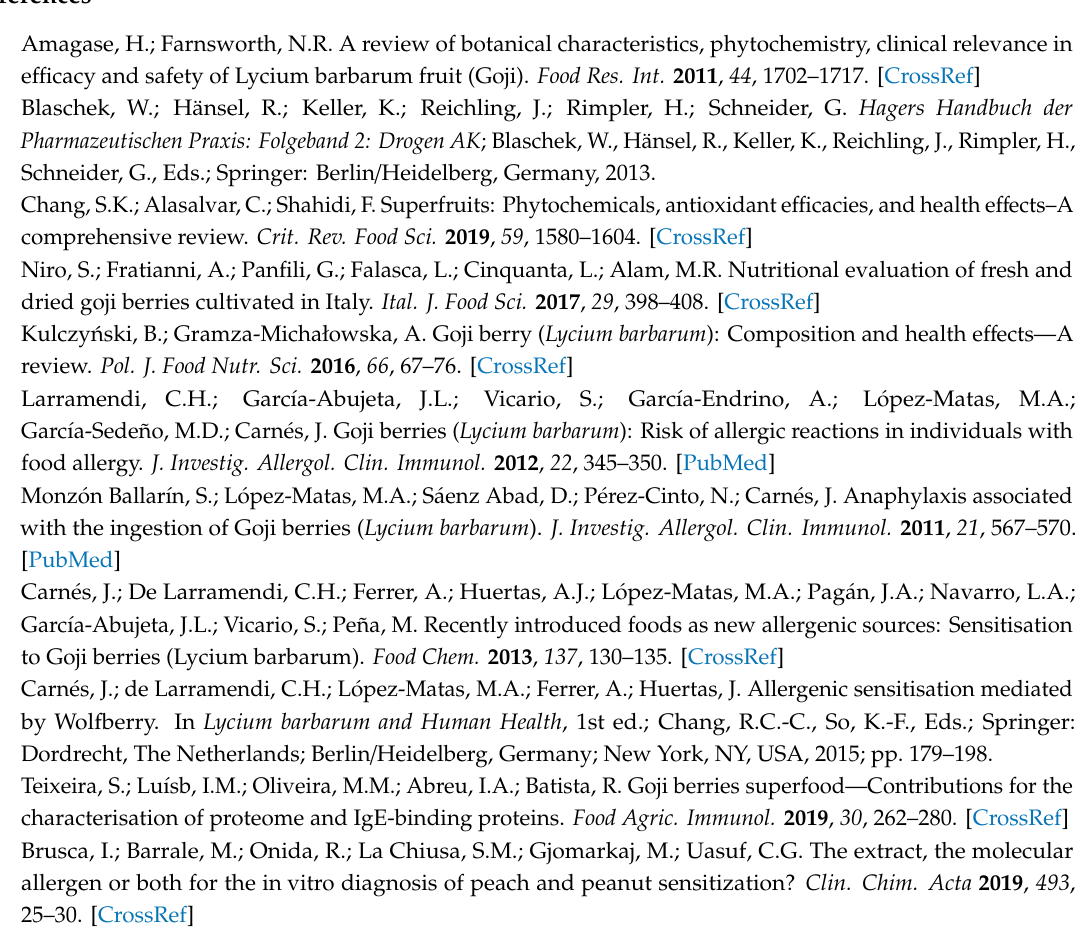
Table S1: Full list of the total protein hits retrieved by Proetome discoverer software screening; Table S2: Cross-reactivity of the protein identified in the total GB digest by proteomic discovery MS analysis and by searching and aligning the full length sequences on